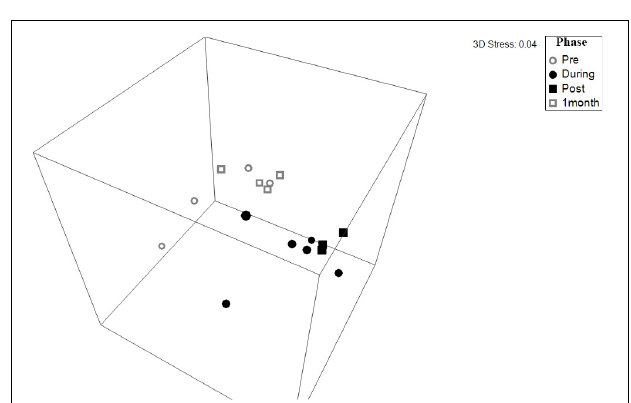
FIGURE 5 | Non-dimensional plot of multidimensional scaling (NMDS) of prokaryotic communities in freshwater wetland soils across each phase of environmental watering, derived from the UNiFRAC matrix of the 16S rRNA gene fragments (stress = 0.04). Points that are closer in the NMDS plot indicate samples with more similar beta-diversity community structure. The pairwise PERMANOVA showed that microbial communities during the “Pre” dry phase (gray) were significantly different from the communities present in the wet phases (black) ( p ≤ 0.006). The 1 Month phase was only marginally insignificant compared to the wet phases ( p ≤